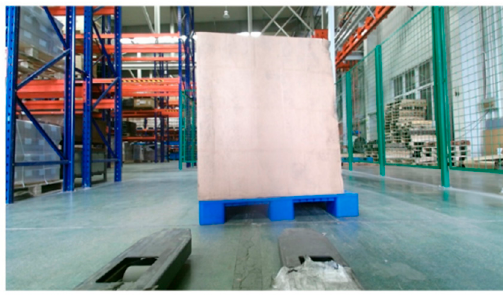
Figure 11. Color image of the original ground scene.